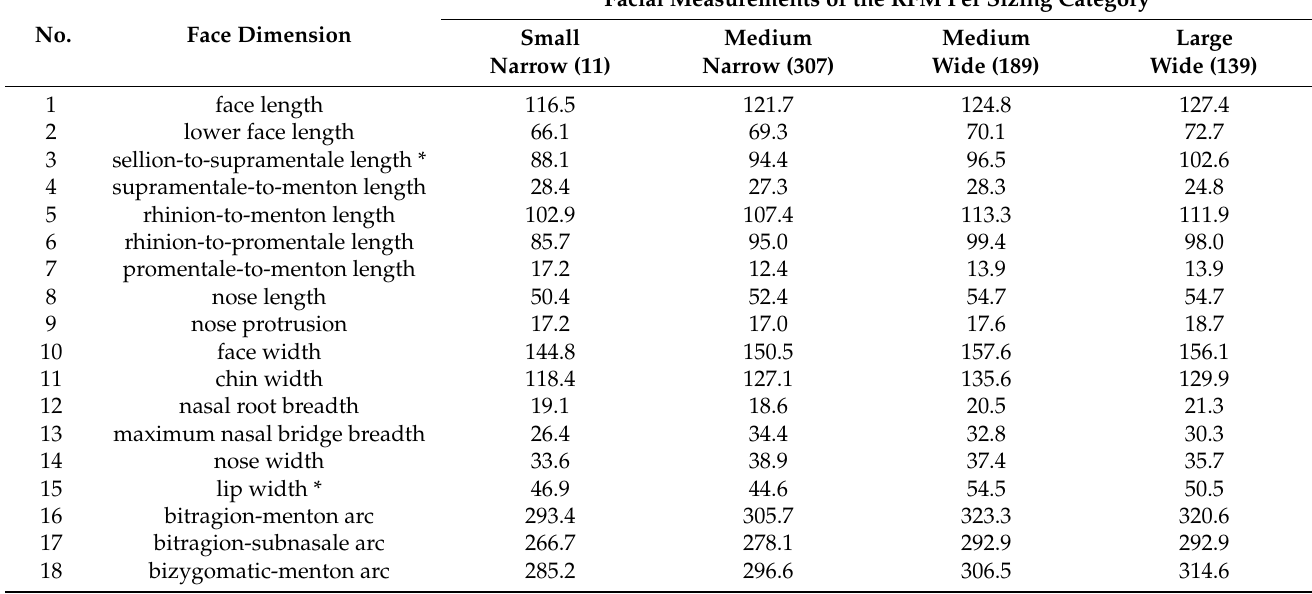
Table 5. Selected representative face models (RFMs) of KAF pilots and their facial sizes (key dimensions of the sizing system are in bold; pilot identification numbers are indicated in parentheses; unit: mm).